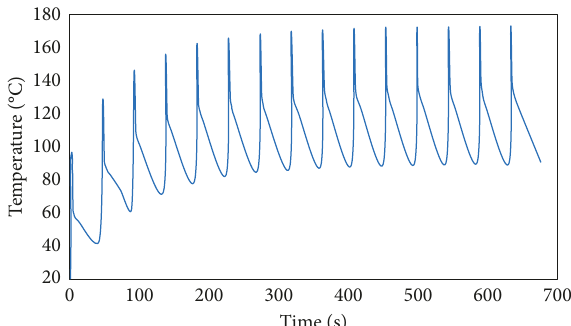
Figure 20: Temperature change curve of disc surface in repeated